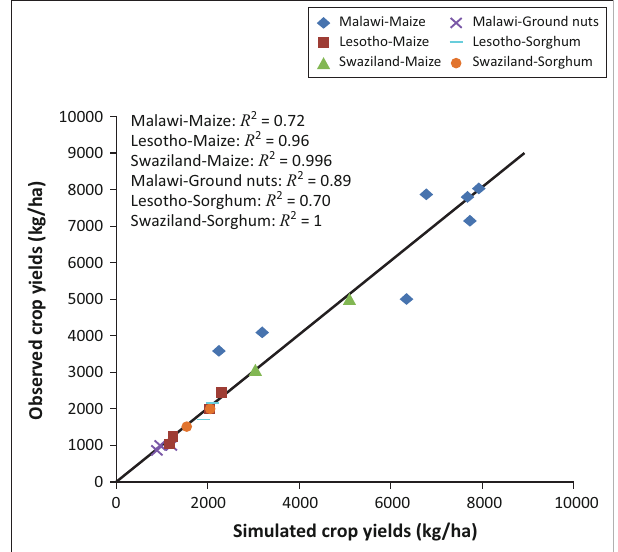
FIGURE 2: Relationship between observed and simulated crop yields Malawi and Swaziland.